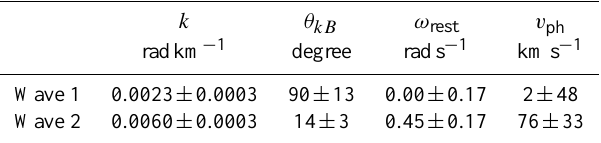
Table 1. Wave properties at spacecraft-frame frequency 1.5Hz: wave number k , angle between the wave vector and the mean mag- netic field θ kB , frequency in the plasma rest frame ω rest , and phase speed in the rest frame v ph